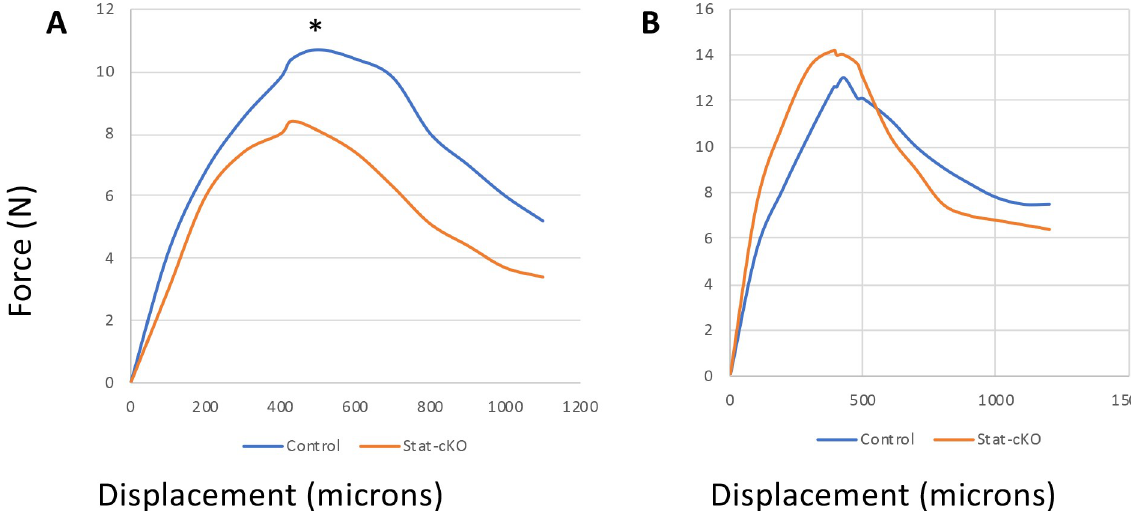
Fig 4. Mechanical testing of female (A) and male (B) STAT3-cKO and control (CN) femurs showing force-displacement curves. Femurs from 8 week old female (A) and male (B) STAT3-cKO and control mice were subjected to 3-point bending to determine femur mechanical properties. Femurs were arranged with their anterior side facing downward, and were loaded with bottom points set 6 mm apart and with the top bending point set in the center. A significant difference was detected between the control female and STAT3-cKO female femurs in total work (A) but not in male control and male STAT3-cKO femurs (B) ( � : p < 0.05, n =